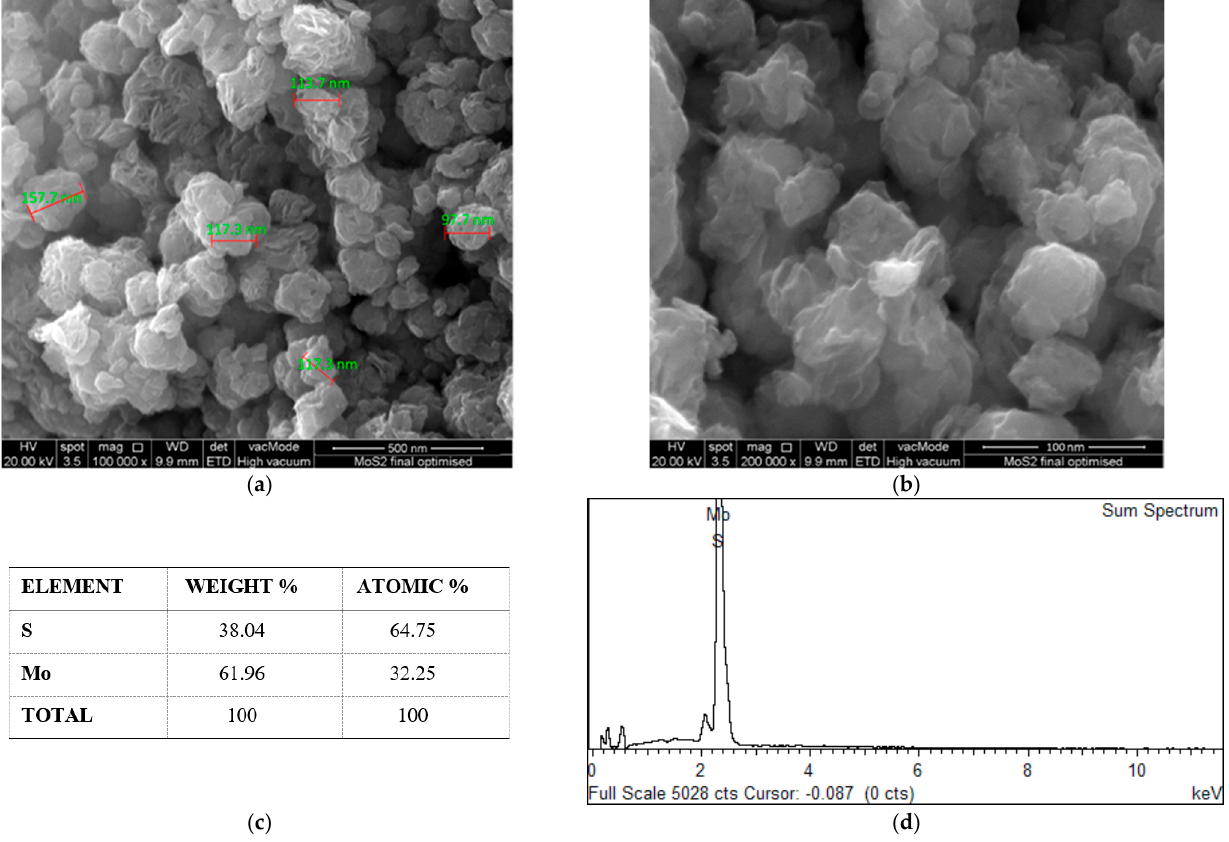
Figure 14. The MoS 2 nanoparticles. ( a , b ) FESEM of the MoS 2 nanoparticles at two magnification levels. ( c ) Composition of the MoS 2 nanoparticles. ( d ) EDS spectrum of the MoS 2 nanoparticles.